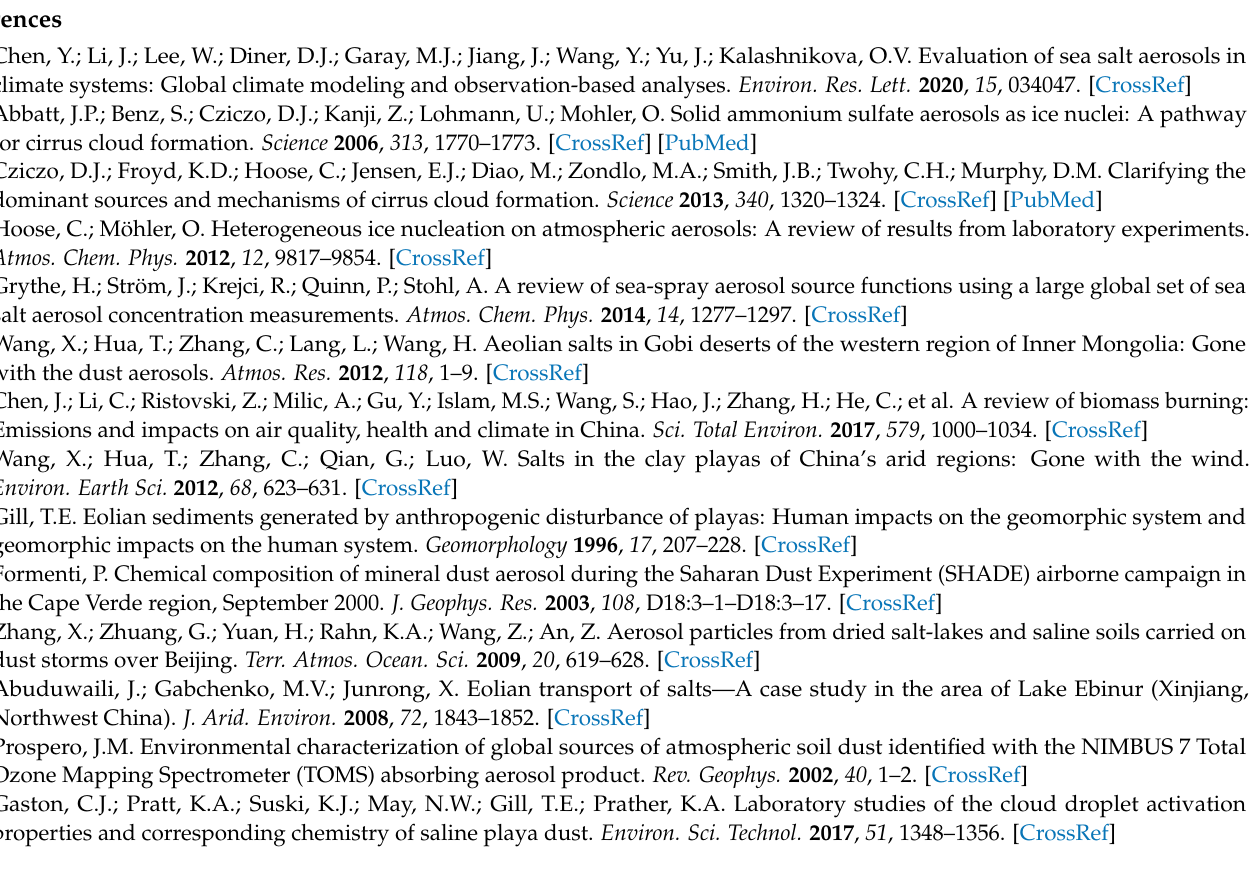
lines are DRH for individual salts in the corresponding salt mixture. The vertical dashed lines are the DRH found by the AIOMFAC model; Figure S1c: AIOMFAC modelled IAP as a function of RH (brine samples). The horizontal dashed lines are DRH for individual salts in the corresponding salt mixture. The vertical dashed lines are the DRH found by the AIOMFAC model; Figure S1d: AIOMFAC modelled IAP as a function of RH (brine samples). The horizontal dashed lines are DRH for individual salts in the corresponding salt mixture. The vertical dashed lines are the DRH found by the AIOMFAC model; Table S1: Molar concentration (mol/l) of all samples; Table S2: DRH predicted by the AIOMFAC model; Table S3: Correlations of the DRH and ions in brine samples; Table S4: Correlations of the DRH value of four kinds of salts in brine